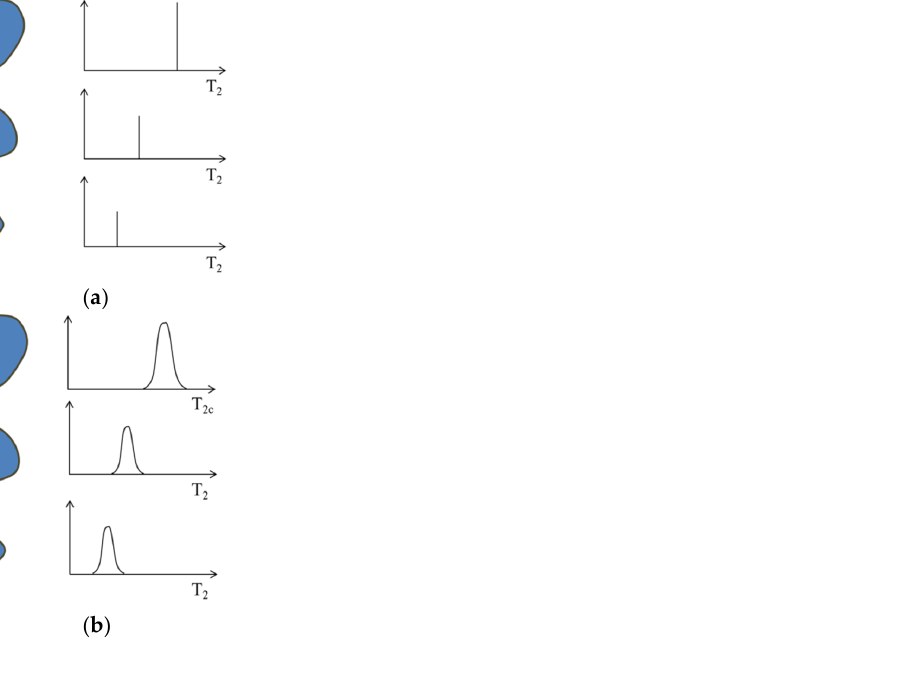
Figure 9. ( a ) Analysis mode of NMR T 2 under ideal conditions; ( b ) analysis mode of NMR T 2 in its actual